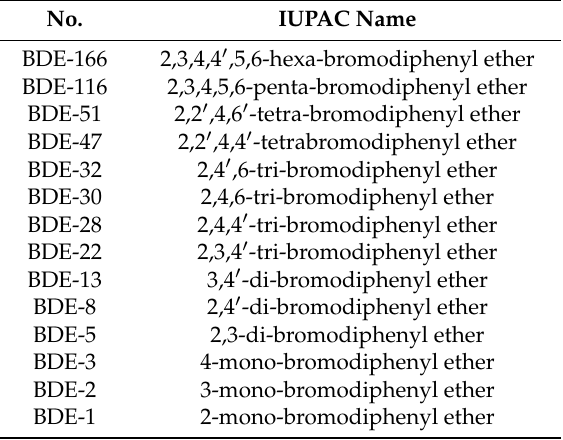
Table 1. IUPAC names and the congener numbers of the selected BDE